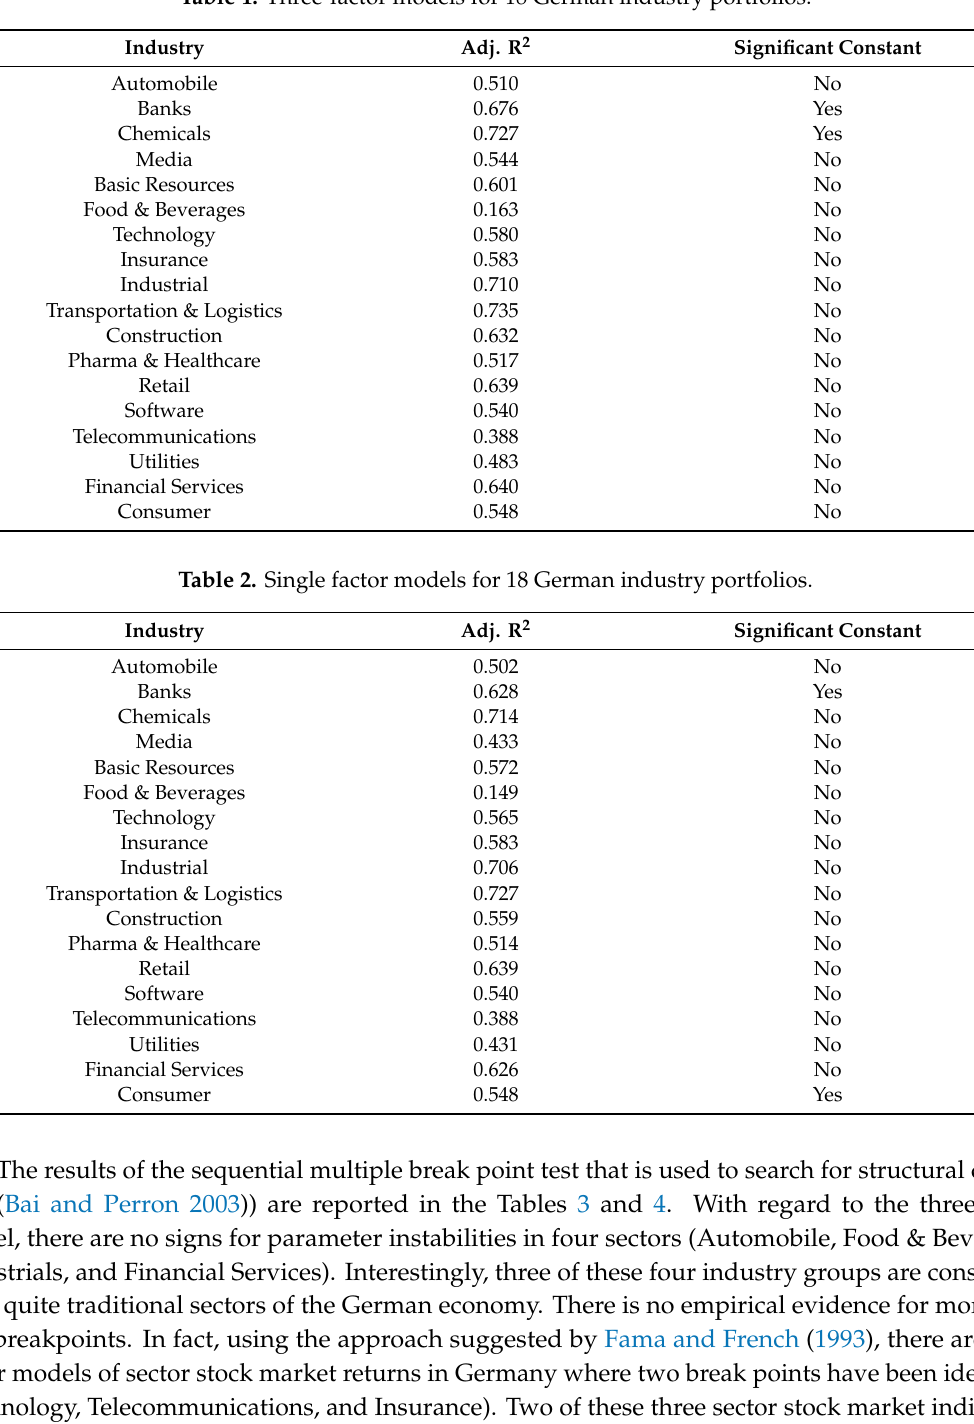
Table 1. Three-factor models for 18 German industry portfolios.